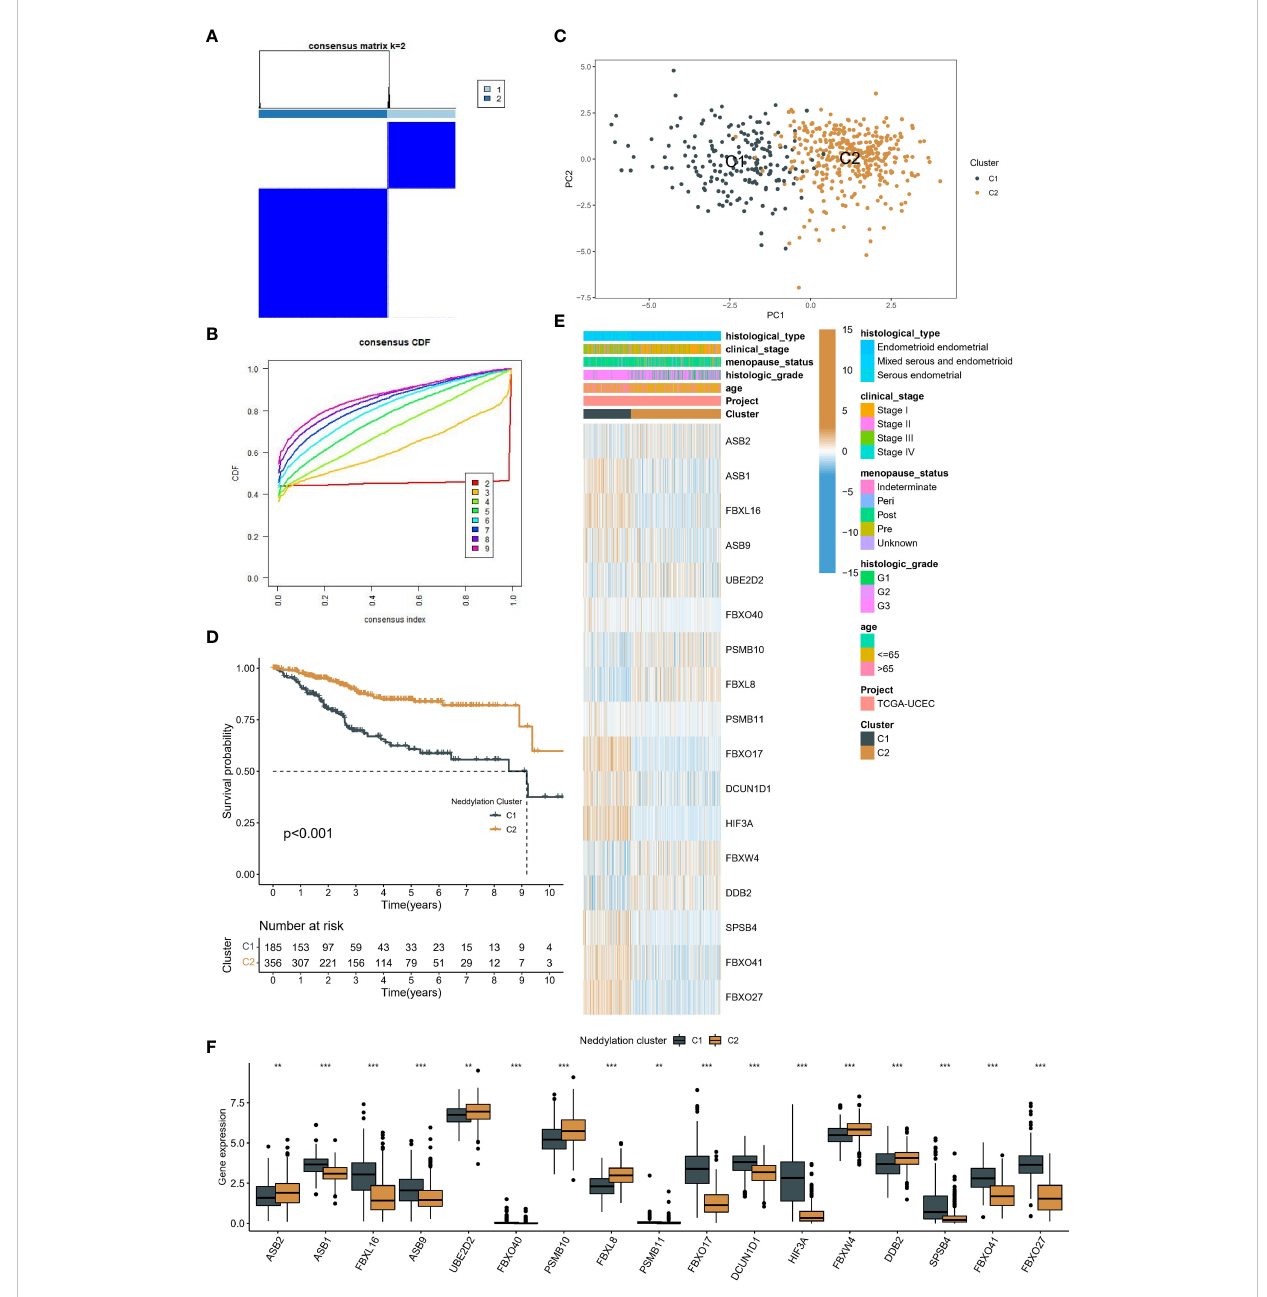
FIGURE 3 Identi fi cation of two patterns associated with neddylation in EC patients. (A, B) The optimal number of clusters based on the cumulative distribution curve. (C) PCA in two patterns. (D) Kaplan-Meier analysis of prognosis between the two patterns. (E-F) Differences in clinical characteristics and prognostic NRGs expression between the two patterns. **p < 0.01, ***p <